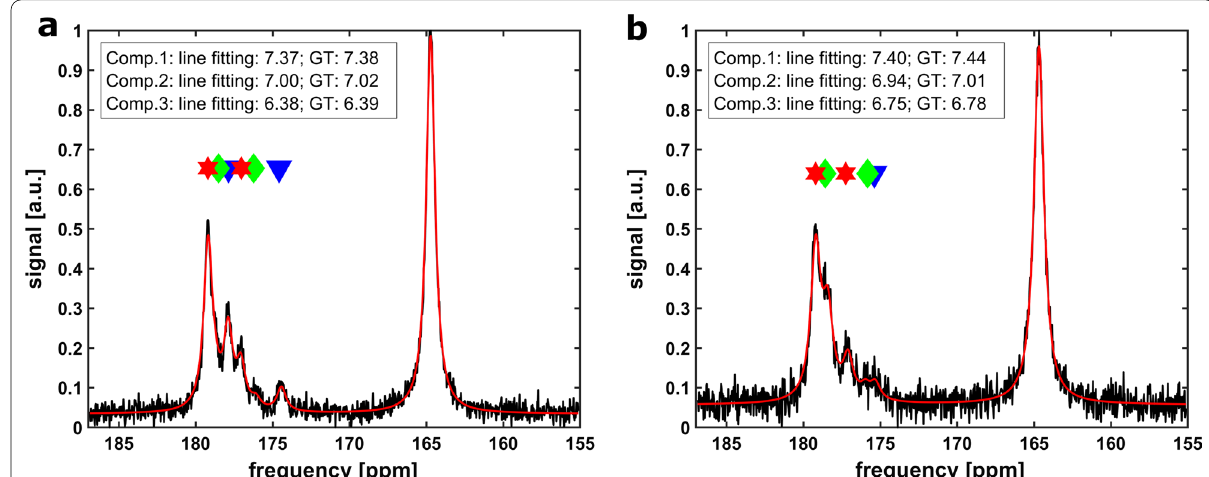
Fig. 4 a Conventional line fitting of a synthetic kidney spectrum with three fitted pH e compartments indicated by coloured markers (compartment 1: red stars, compartment 2: green diamonds, compartment 3: blue triangles) and comparison of calculated pH e values and ground truth data is shown as inset resulting in good agreement. b Conventional line fitting on a noisy spectrum and low compartment intensities of the medulla and the ureter. Three compartments can only be partially detected and agreement with ground truth is rather